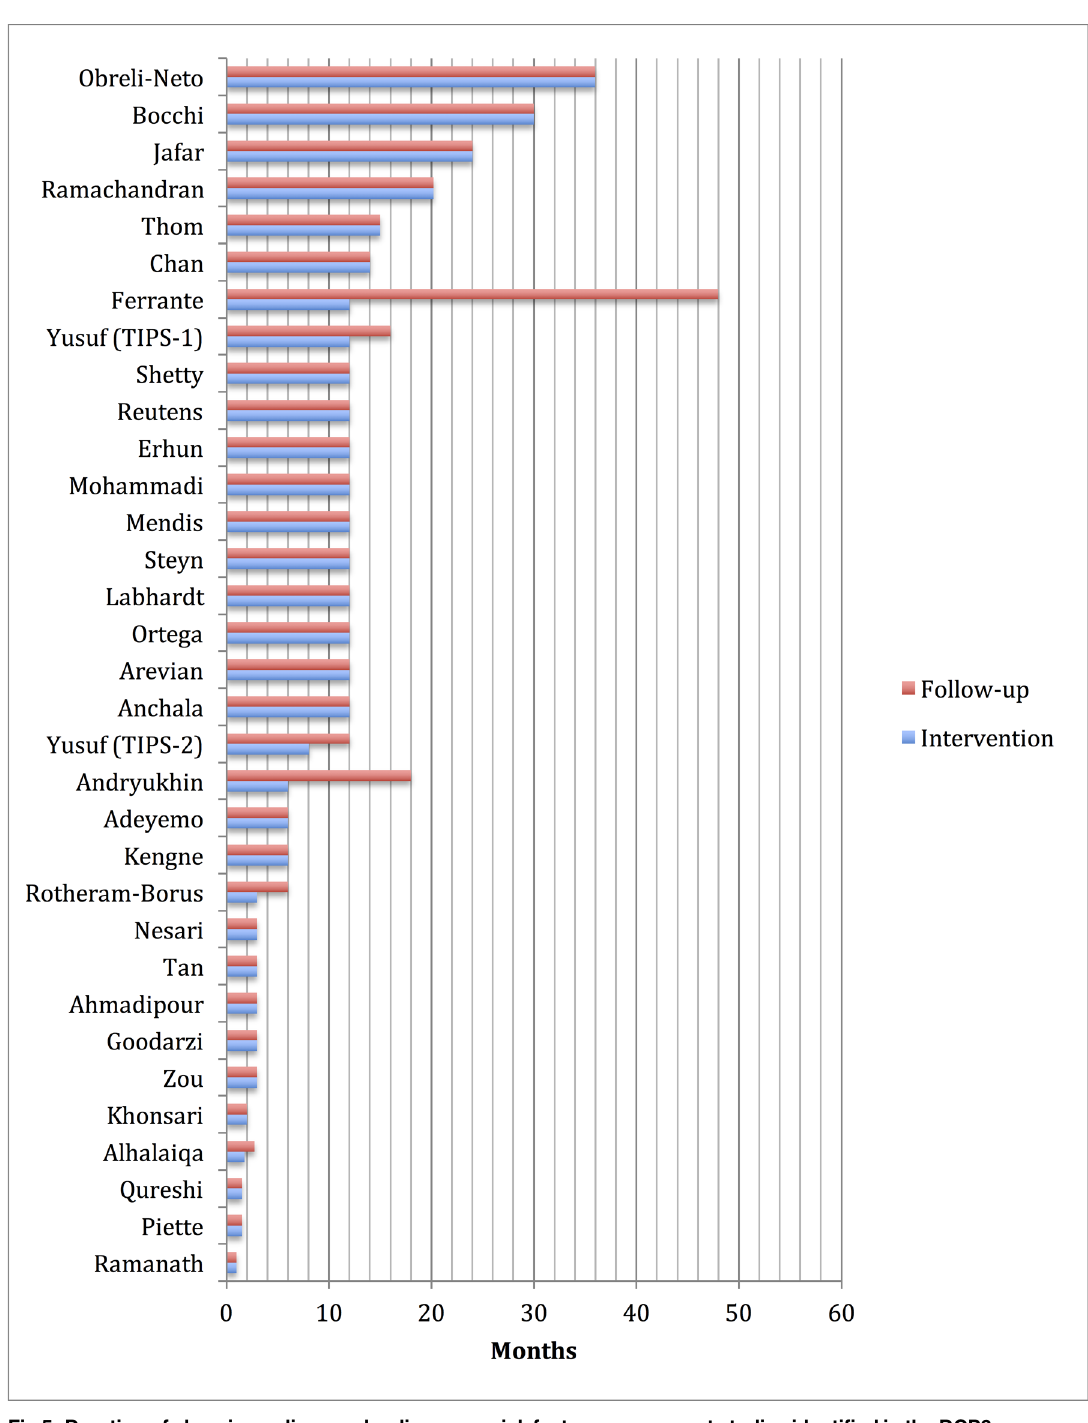
Fig 5. Duration of chronic cardiovascular disease or risk factor management studies identified in the DCP3 systematic